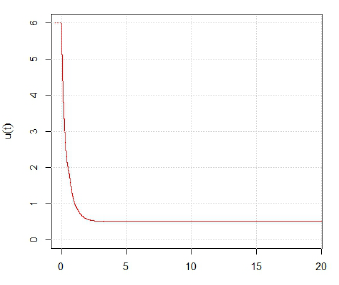
Figure 4. Trajectory of u ( t ) for DDE (22) with c = 2.